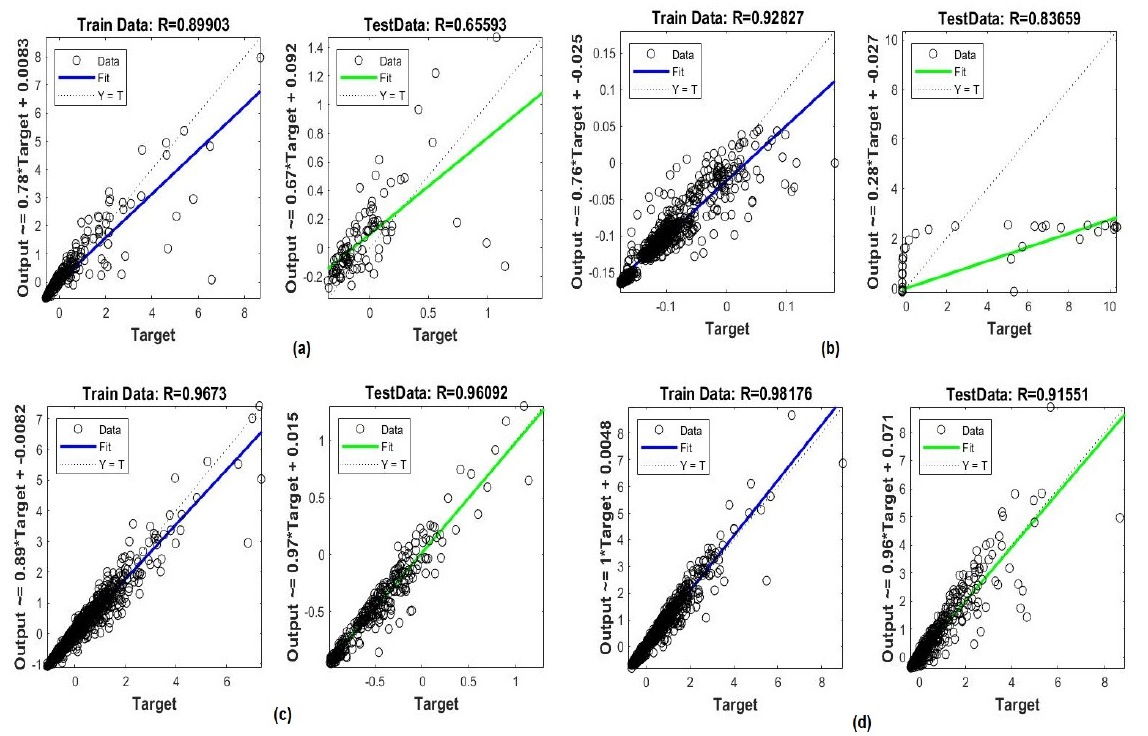
Figure 17. Regression plot of the LSTM model for ( a ) AMP, ( b ) Ethereum, ( c ) EOS, and ( d ) XRP.